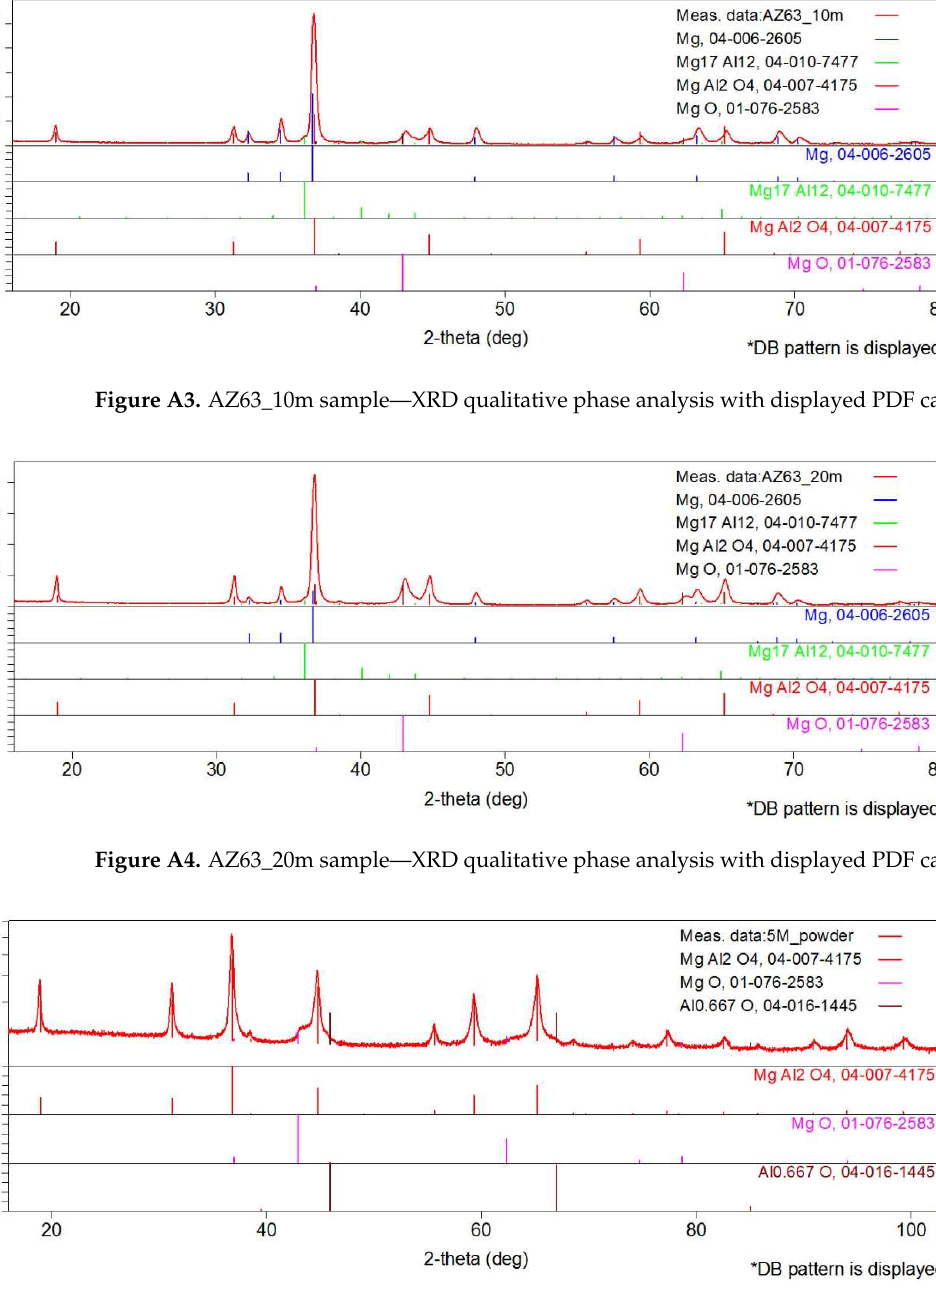
Figure A5. AZ63_5m in powder-form sample—XRD qualitative phase analysis with displayed PDF cards peak bars.